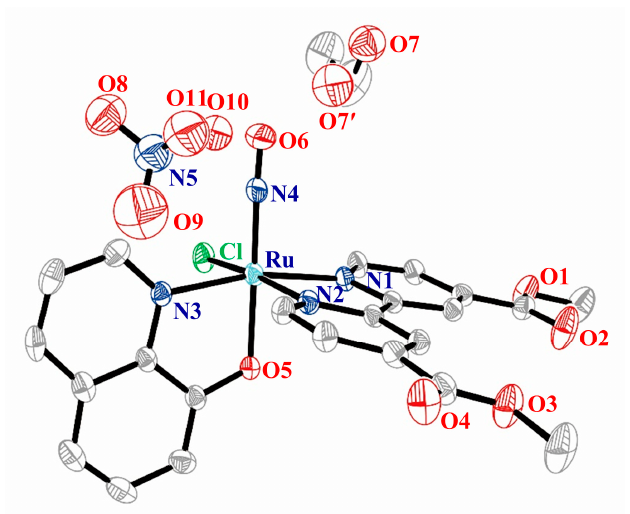
Figure 1. Ortep diagram of Ru-Lbpy 2 , showing 30% thermal ellipsoid probability. All hydrogen atoms in the unit cell of the complex are omitted for